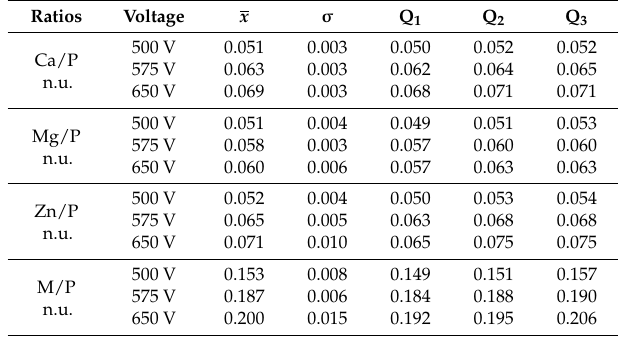
Table 4. Statistical description of EDS of coatings formed in Electrolyte 1. n.u., no units. Ratios Voltage x